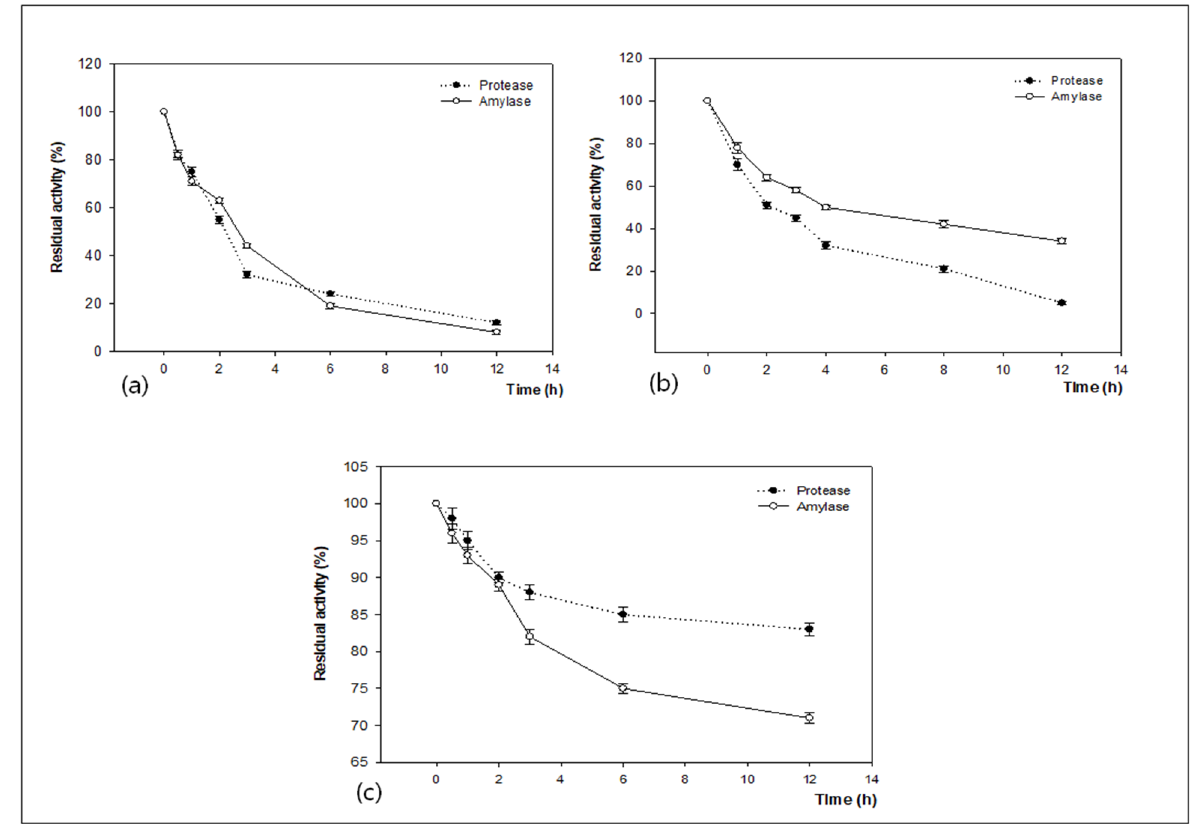
Figure 4. The stability of enzymes at different extreme and optimal temperatures ( a ) − 6 °C, ( b ) 75 °C, and ( c ) 45 °C.